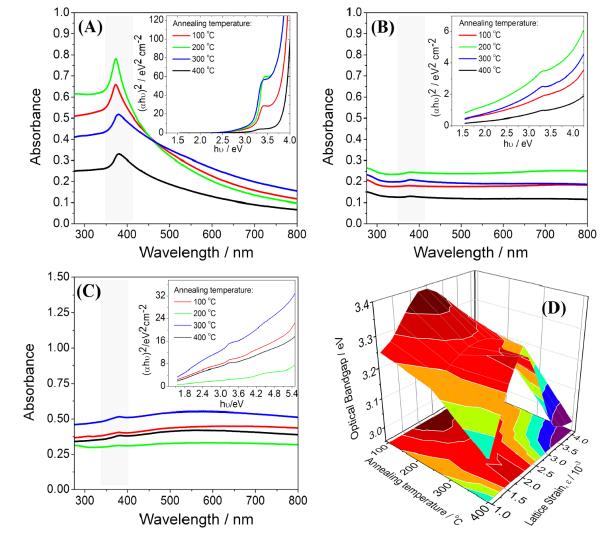
Figure 7: Absorption spectra of (A) ZnO SPs, (B) ZnO NFs, and (C) ZnO NRs at various low annealing temperatures. The inset shows the Tauc-plot determining the optical bandgap of ZnO. (D) The map of bandgap energy tunability from ZnO nanostructures studied here which is dependent to the lattice strain induced by annealing temperature.